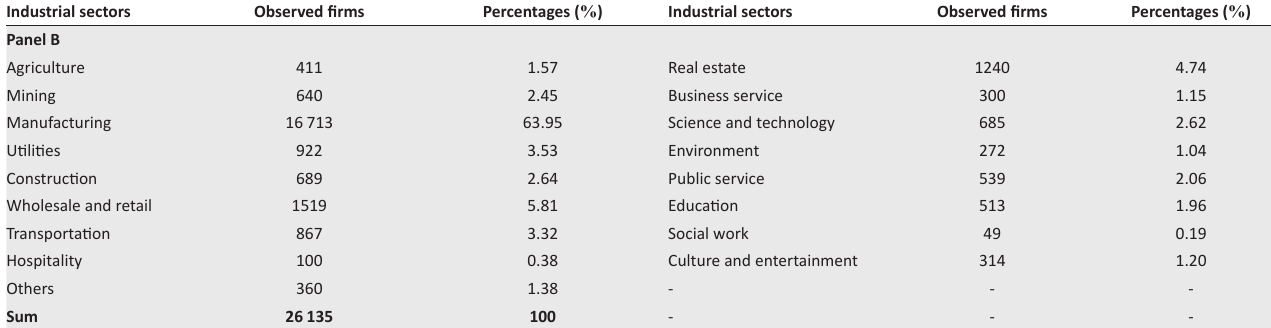
TABLE 5b: Sample distribution by years and industrial